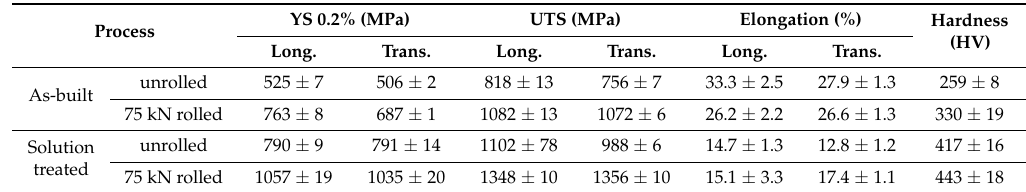
Table 1. Mechanical test results of Inconel 718 parts in the longitudinal (Long.) and transversal (Trans.) directions (adapted from [63]).